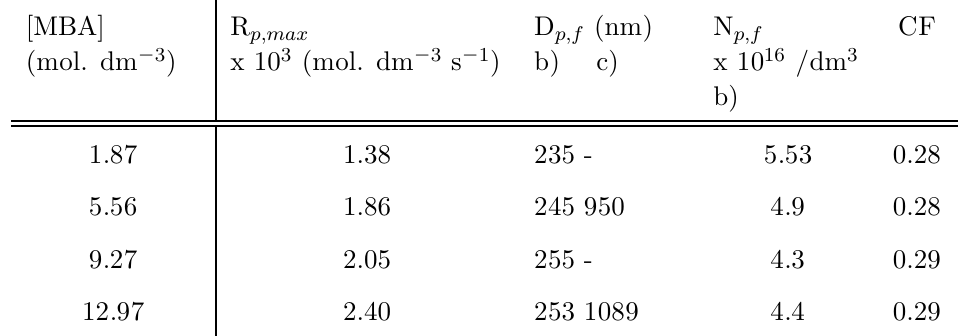
Table 2 Variation of kinetic and colloidal parameters and the contraction factor (CF) in the miniemulsion copolymerization of AAm and MA with the MBA concentration. a )